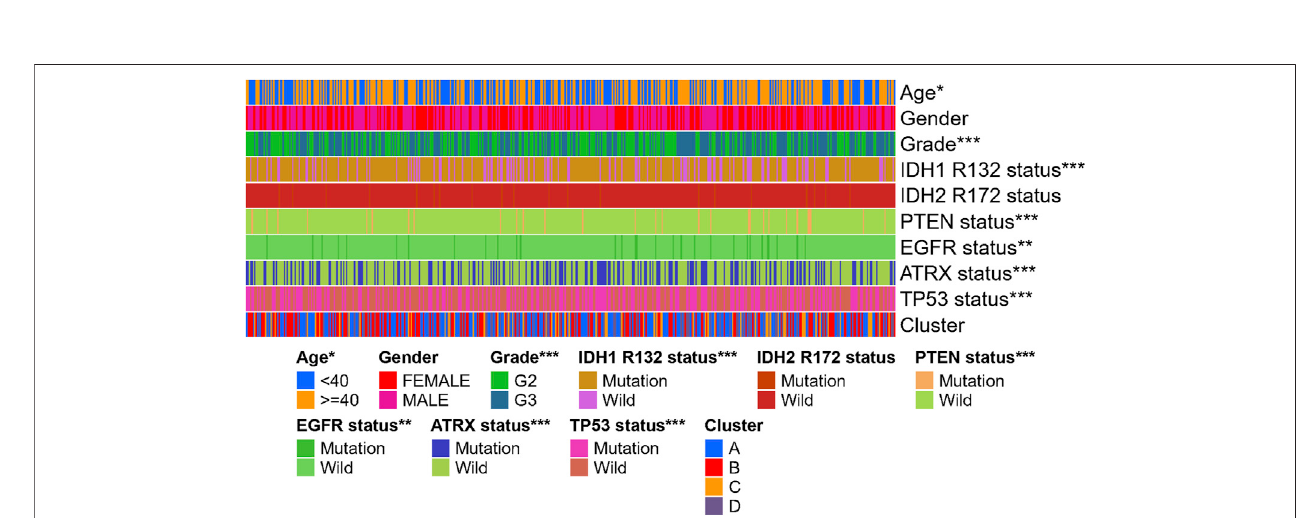
FIGURE 5 | Heat map of clinical features and gene mutation. Characteristics of the four immune subtypes in the TCGA-LGG dataset.